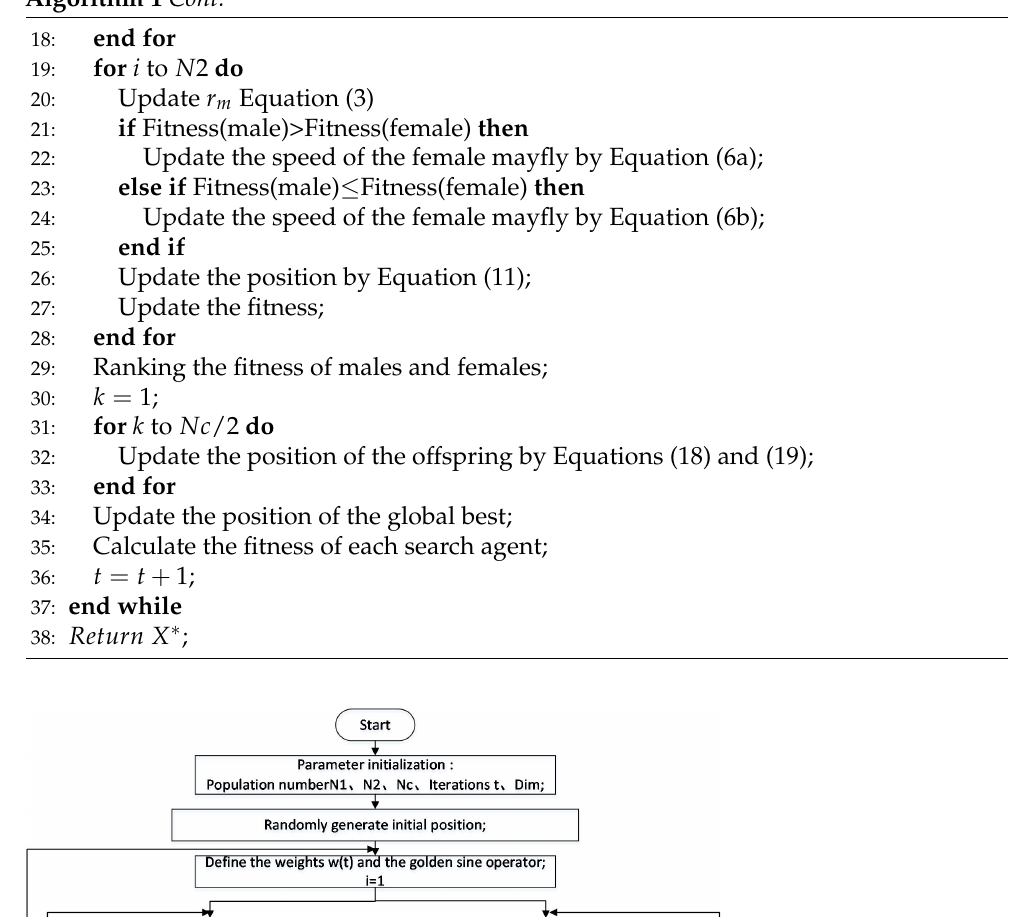
Algorithm 1 Cont.